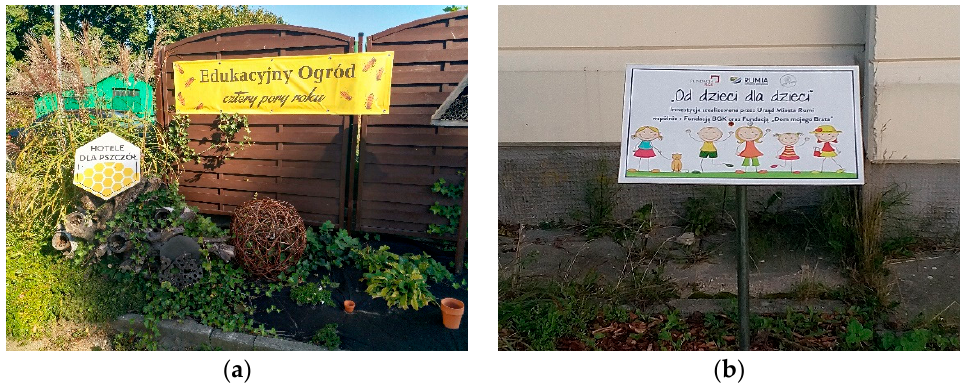
Figure 9. Educational gardens in the summer of 2021 ( a , b ), source: author.